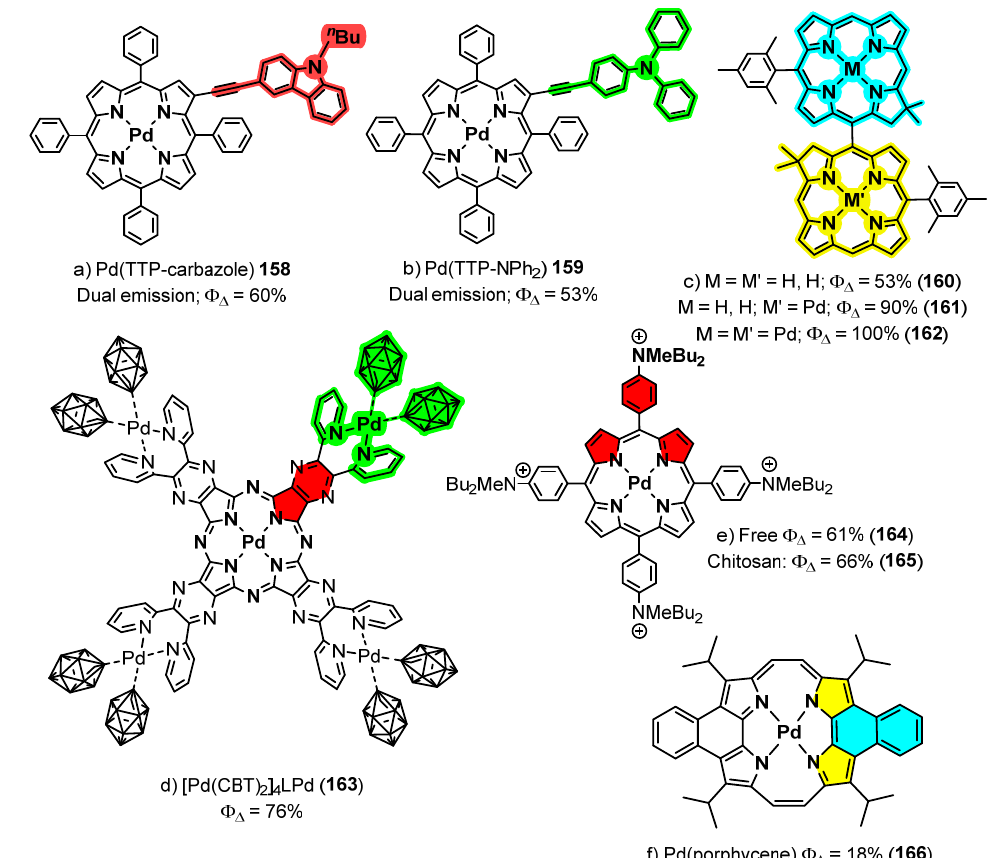
Figure 43. Phorphyrin- and porphyrin-like-containing complexes as photosensitizers for the 1 O 2 production. Adapted from [140 − 145].